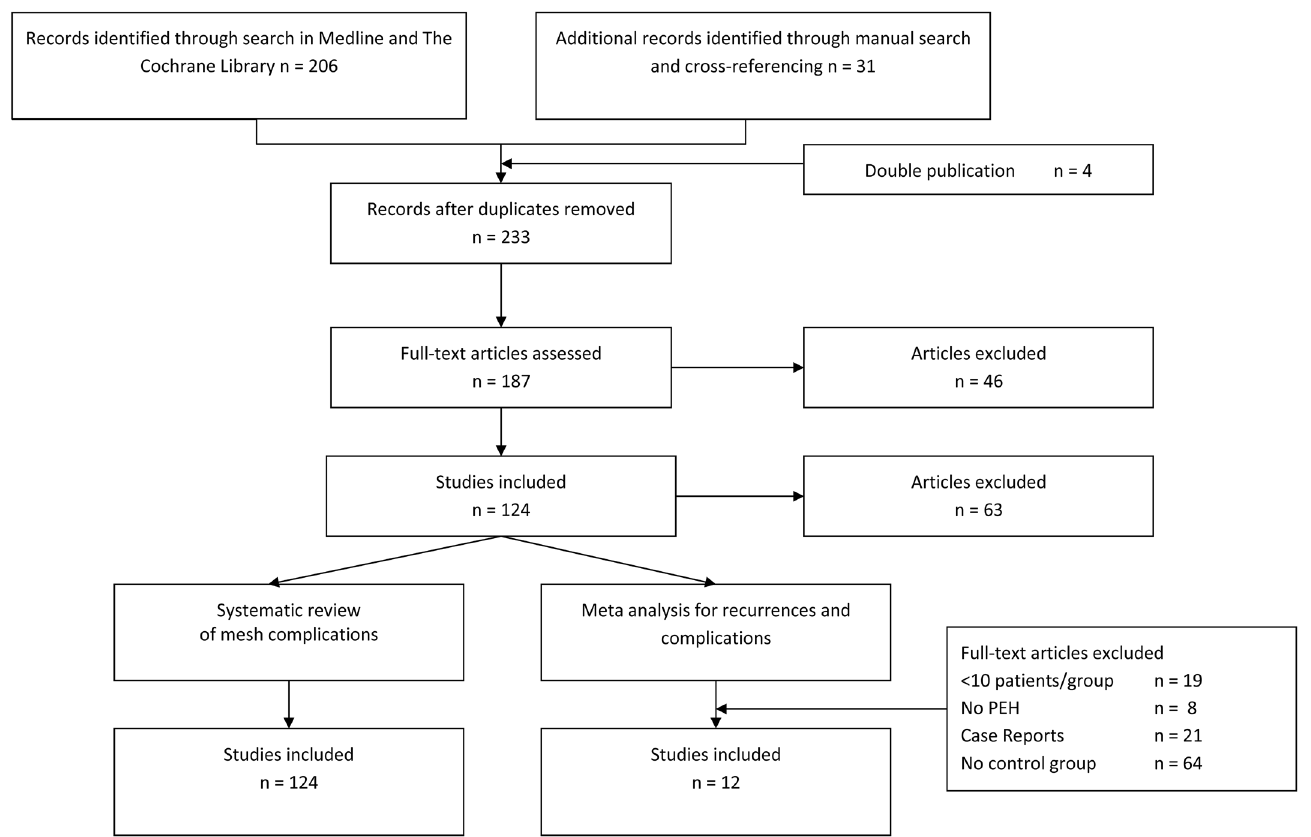
Fig 3. Flow chart of study